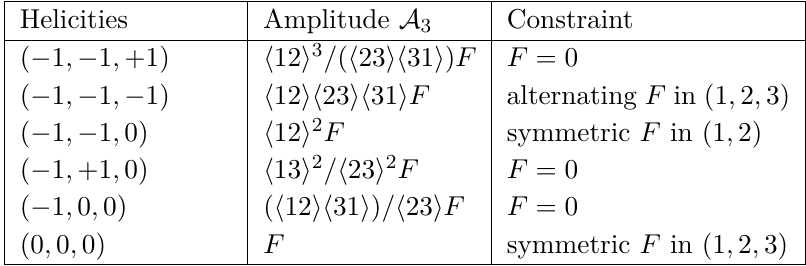
Lets start by constraining the ( − 1 , +1 , 0) amplitude. Consider the four-particle am- plitude A (1 − 1 2 +1 3 − 1 4 +1 ) between four photons. By little group scaling this amplitude 4 takes the general